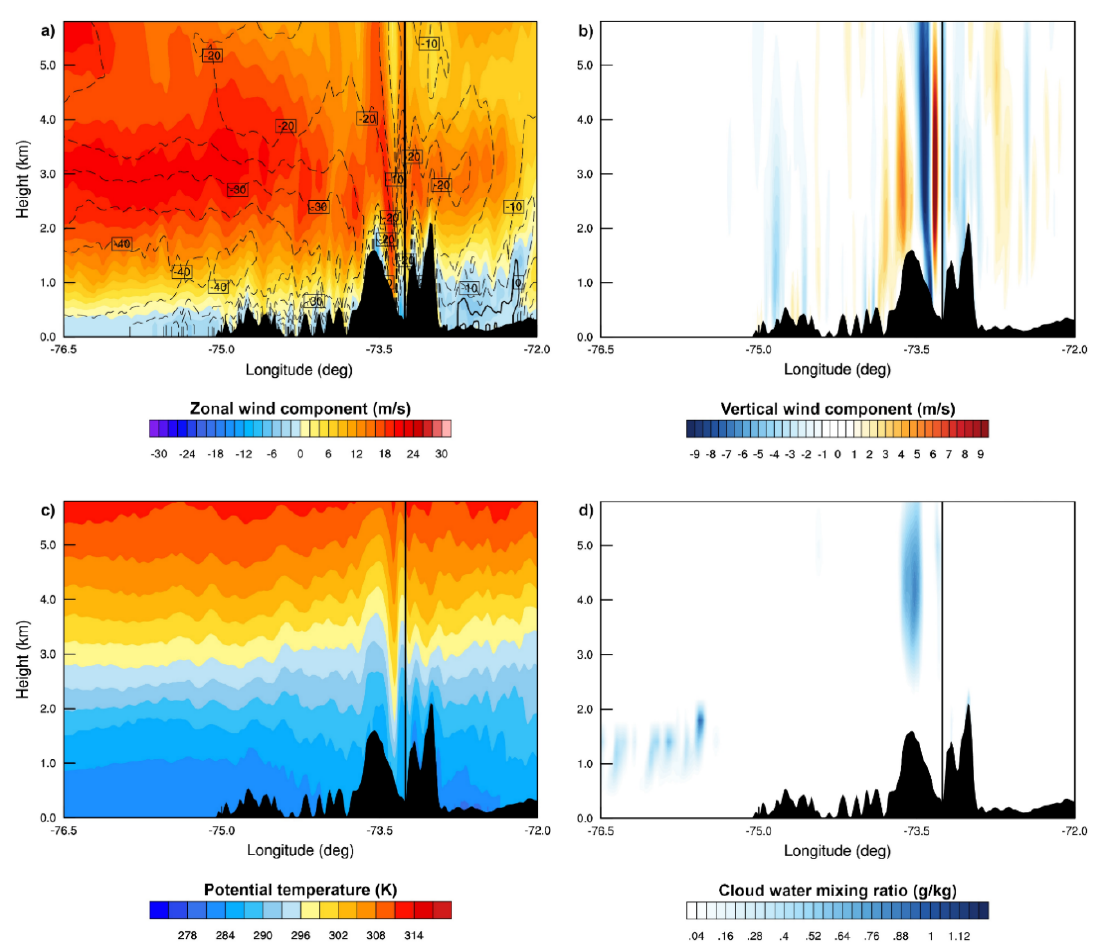
Figure 8. Vertical cross section (90° angle) of ( a ) zonal (color scheme) together with meridional (contour lines) wind component, ( b ) vertical wind component (positive values reveal upward motion, negative values reveal downward motion), ( c ) potential temperature, and ( d ) cloud water mixing ratio for the transition case at 8th August 2018 18:00. The black line indicates the location of NG. Data are derived from WRF.